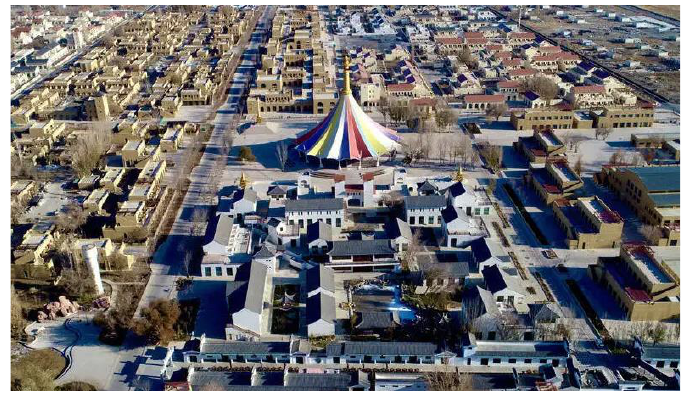
Figure 13. Aerial view of Chagancao village in Xinjiang.